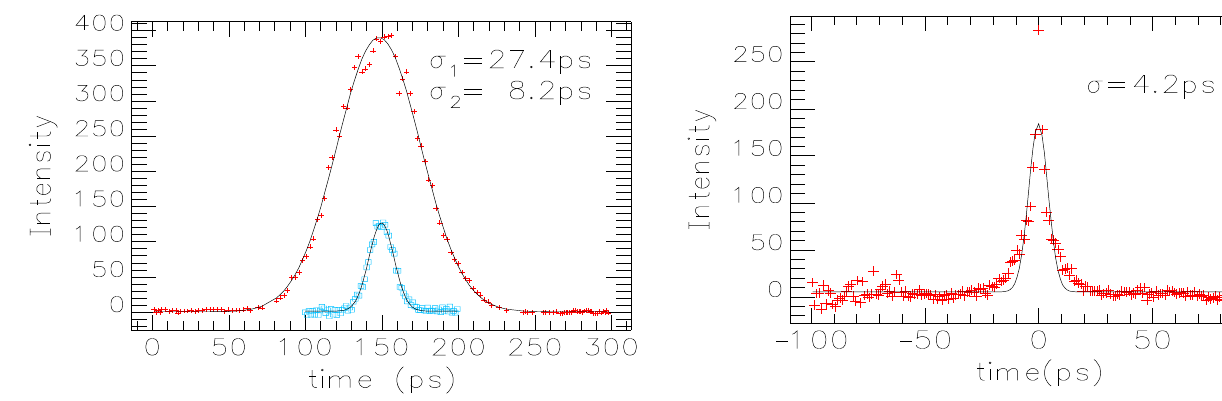
FIG. 7. (Color) The length of the long-time-overlapped pulses. Red crosses, without the slit; blue squares, with the slit.